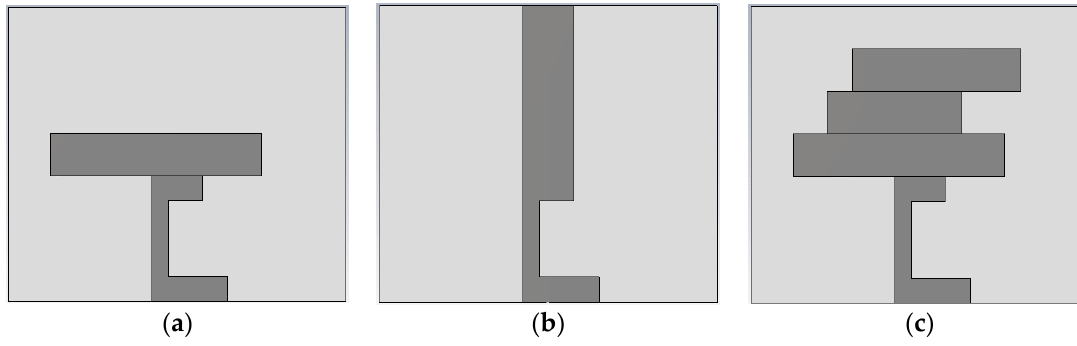
Figure 1. ( a ) Design 1; ( b ) Design 2; ( c ) proposed design.